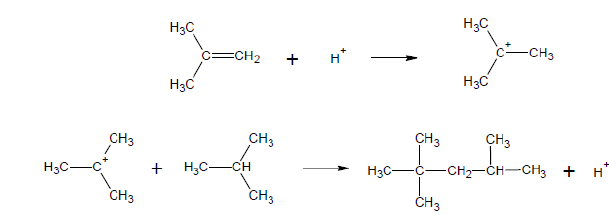
Figure 3. Complete scheme of alkylation reaction